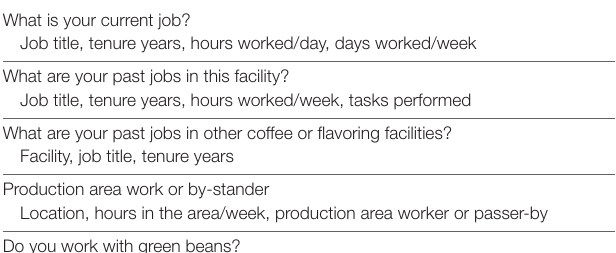
TABLE 2 | Questions used in the exposure module of the questionnaire to assess